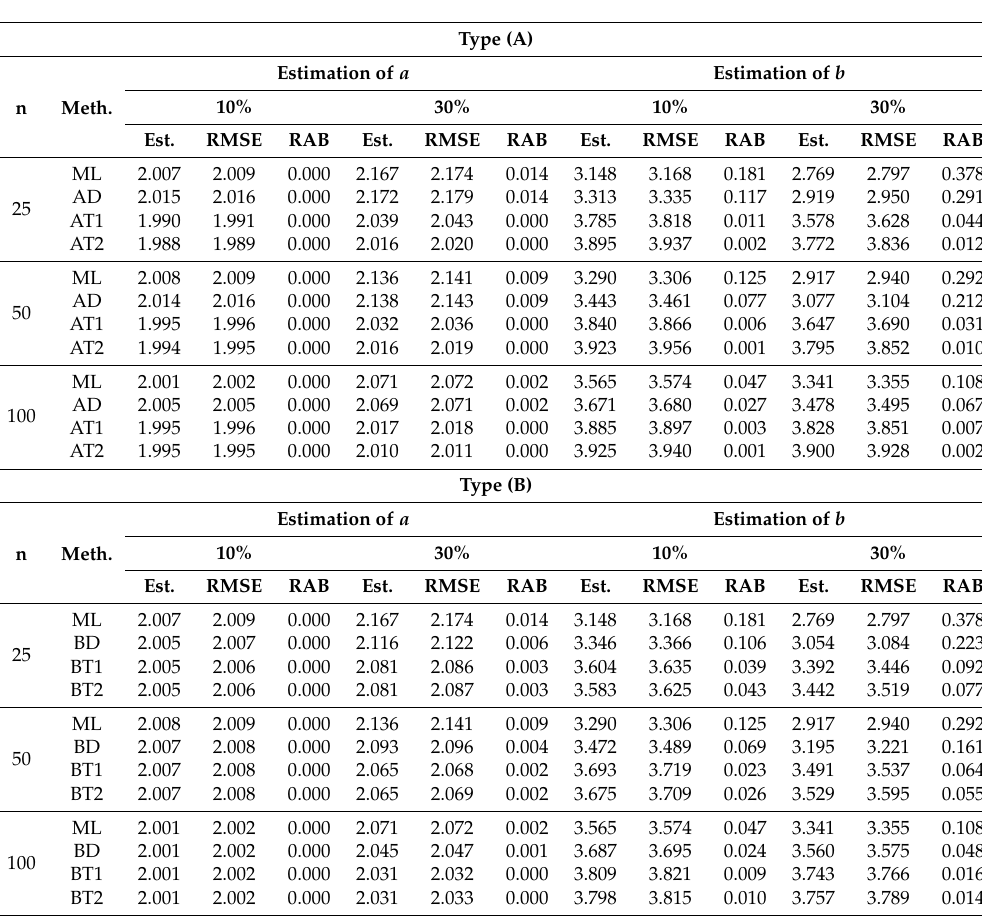
Table 5. The estimates, root of mean square error (RMSE) and relative absolute biases (RABs) for two parameters of the Weibull distribution using TL-moments, direct L-moments, and ML method based on right censoring ( a = 2 and b = 4) in the presence of